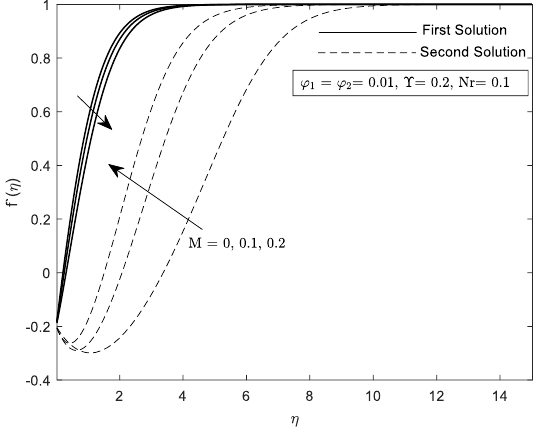
Figure 18. 𝑓 ′ (𝜂) on different 𝑀 .